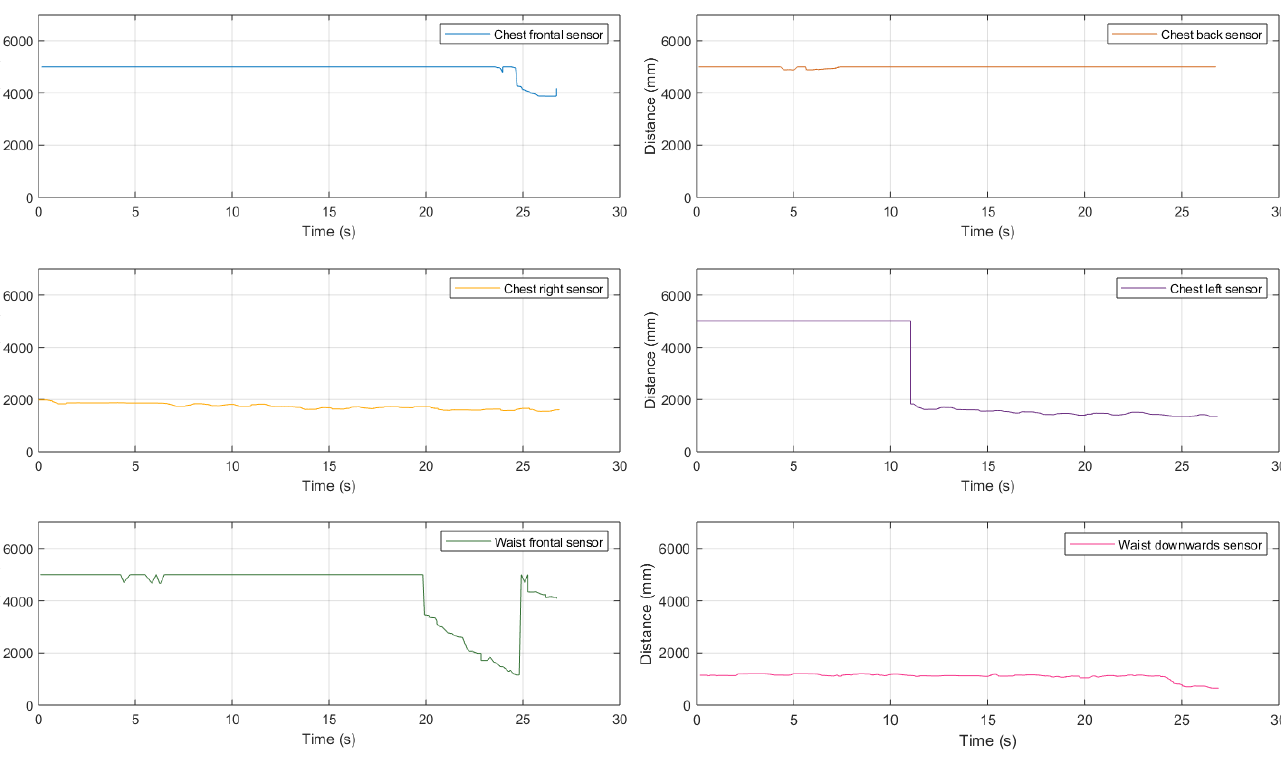
Figure 19. Experimental distance estimates obtained with the configuration shown in Figure 17, in the presence of a 38 × 44 cm medium-size obstacle along the